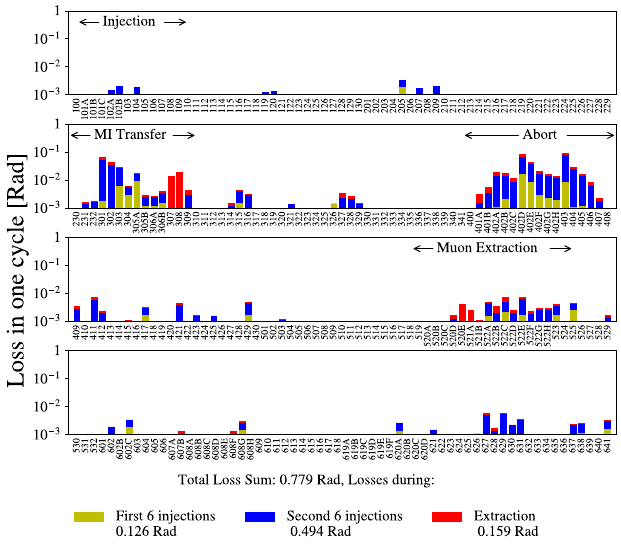
FIG. 7. Typical loss pattern around the Recycler before the 2016 summer shutdown. Intensity is 42 × 10 12 ppp.